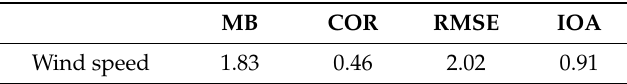
Table 4. Test statistics of the CALMET